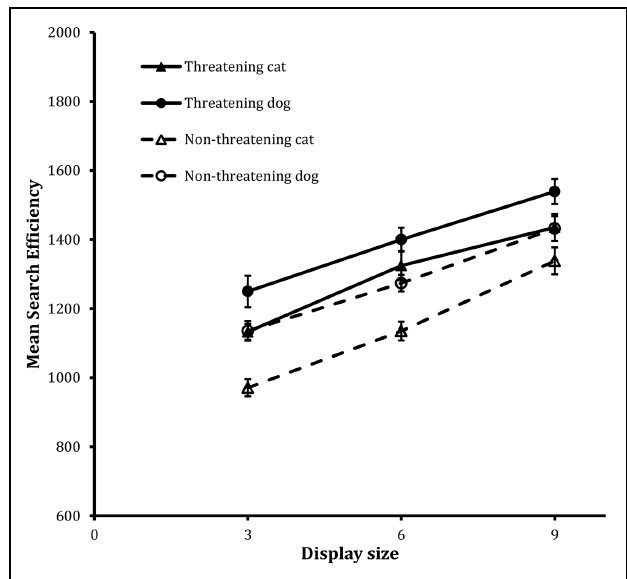
FIGURE 4 | Mean search efficiency scores as a function of both condition and display set size in the classification task in Experiment 2. Error bars reflect within-participant SE after variation between participants was removed (after Bakeman and McArthur, 1996).